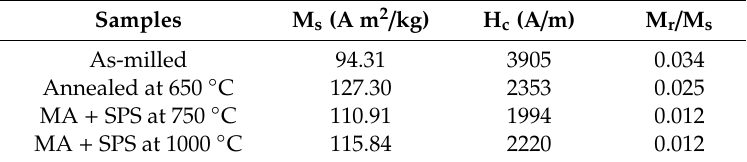
Table 5. Magnetic characteristics of the milled FeCoNiB 0.5 Si 0.5 HEA powder before and after annealing.